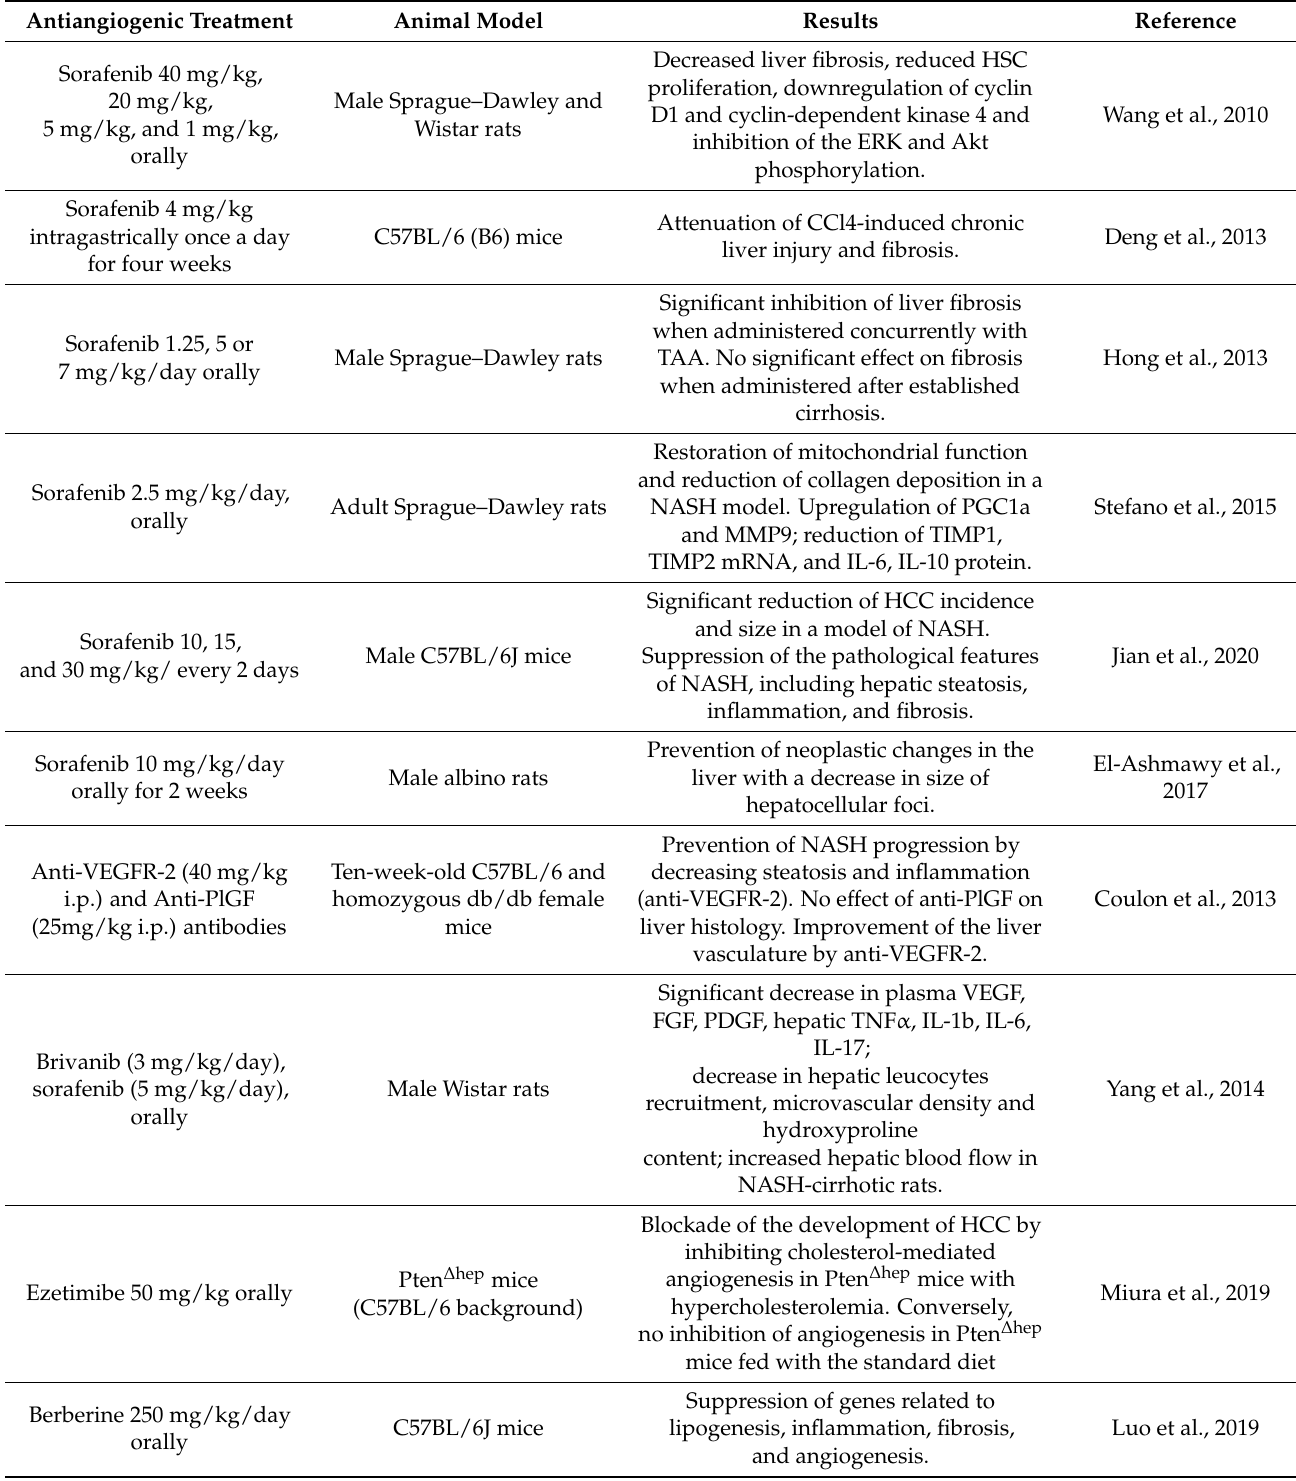
Table 1. Antiangiogenic treatments in animal models of NASH and